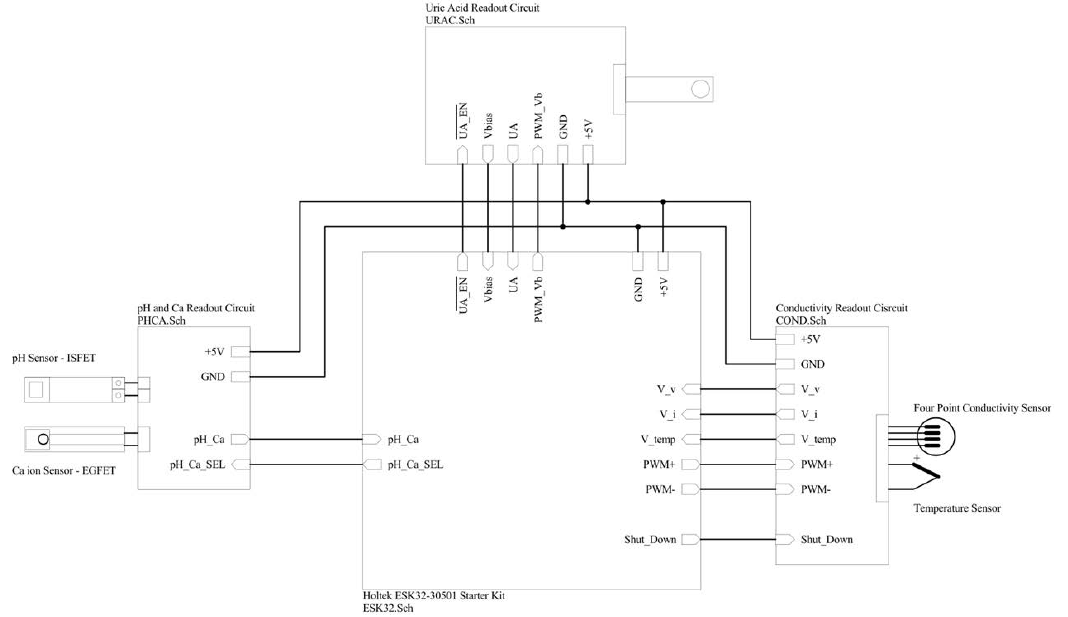
Figure 9. Digital control module connections to readout circuits.